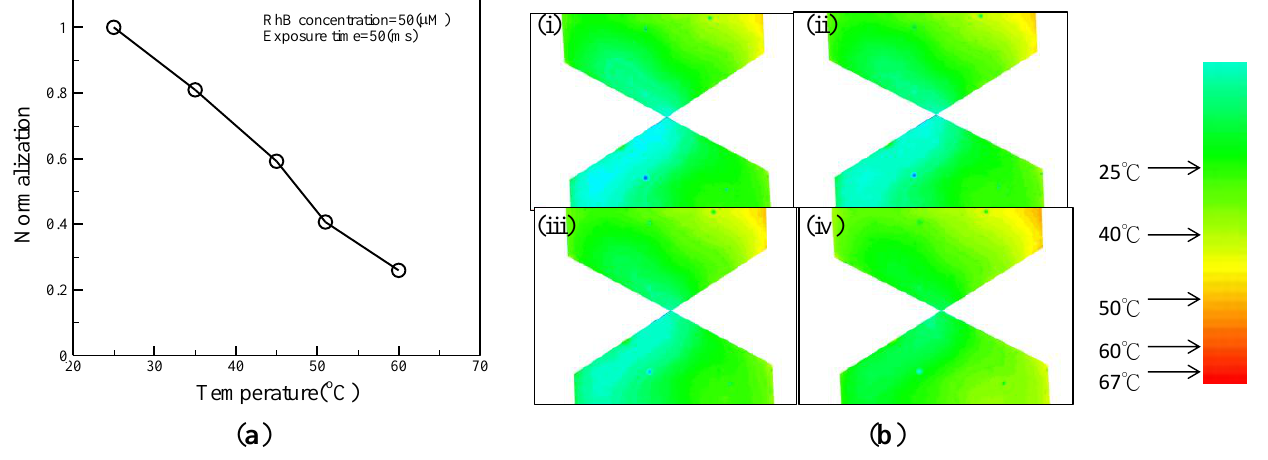
voltage V = 90 V ·cm −1 and a frequency f = 1 kHz. Temperature distribution images pp